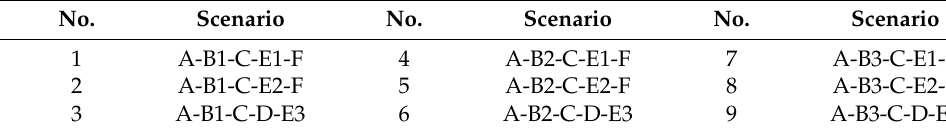
Figure 1. Microalgae oil production scenarios analyzed. Table 2. Technological scenarios for the production of microalgal oil.